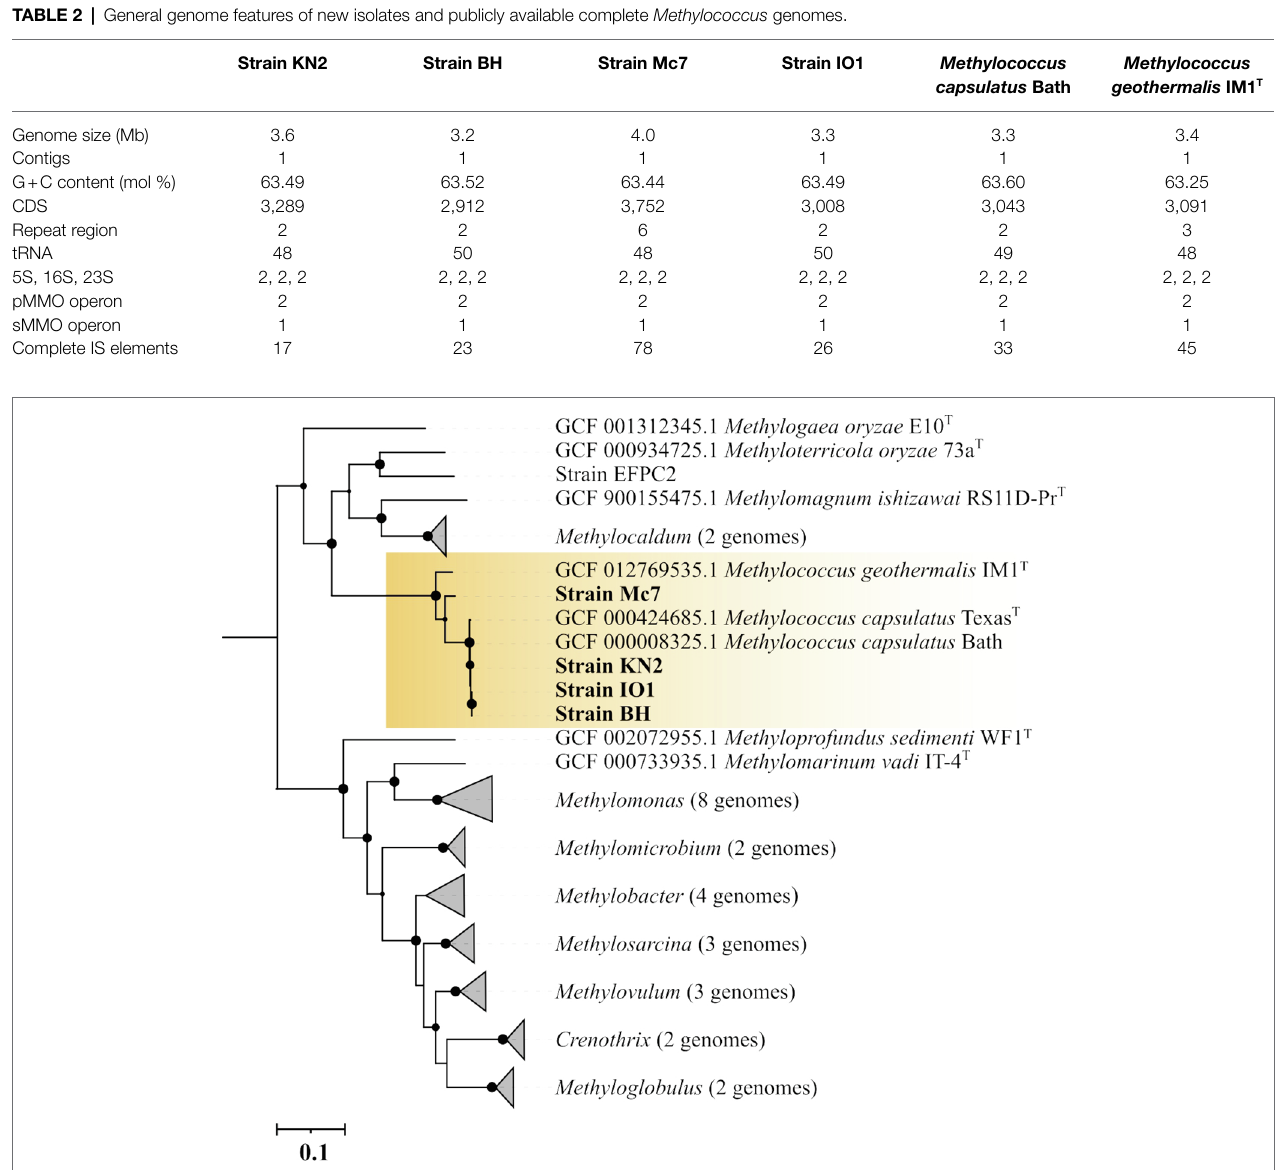
FIGURE 3 | Genome-based phylogeny showing the position of new isolates in relation to other gammaproteobacterial methanotrophs based on the comparative sequence analysis of 120 ubiquitous single-copy proteins. The clade of Methylococcus methanotrophs is highlighted by orange. The tree was constructed using the Genome Taxonomy Database toolkit (Parks et al., 2018), release 04-RS89. The significance levels of interior branch points obtained in maximum-likelihood analysis were determined by bootstrap analysis (100 data re-samplings). Bootstrap values of >70% are shown. The root (not shown) is composed of all genomes available in GTDB for methanotrophs of the genera Methylosinus and Methylocystis . Bar, 0.1 substitutions per amino acid